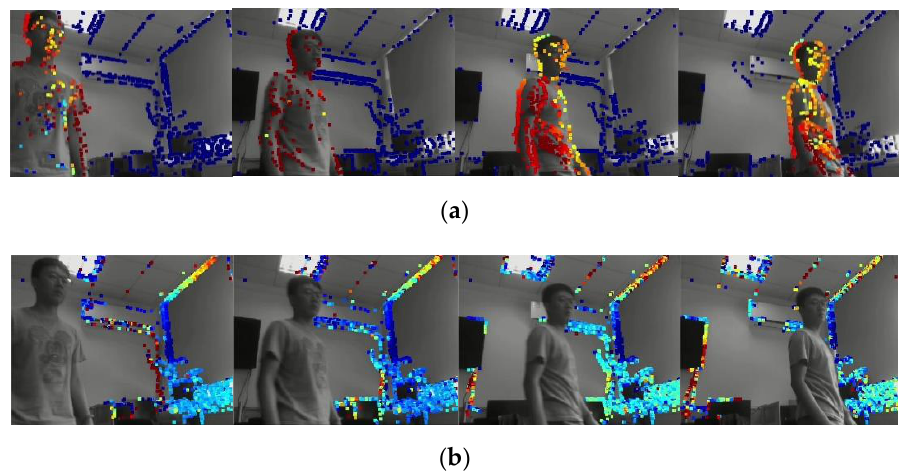
Figure 16. Keyframes selected by DSO ( a ) and Dynamic-DSO ( b ). The colorful points are selected and tracked by the algorithm, and the color represents the depth information.